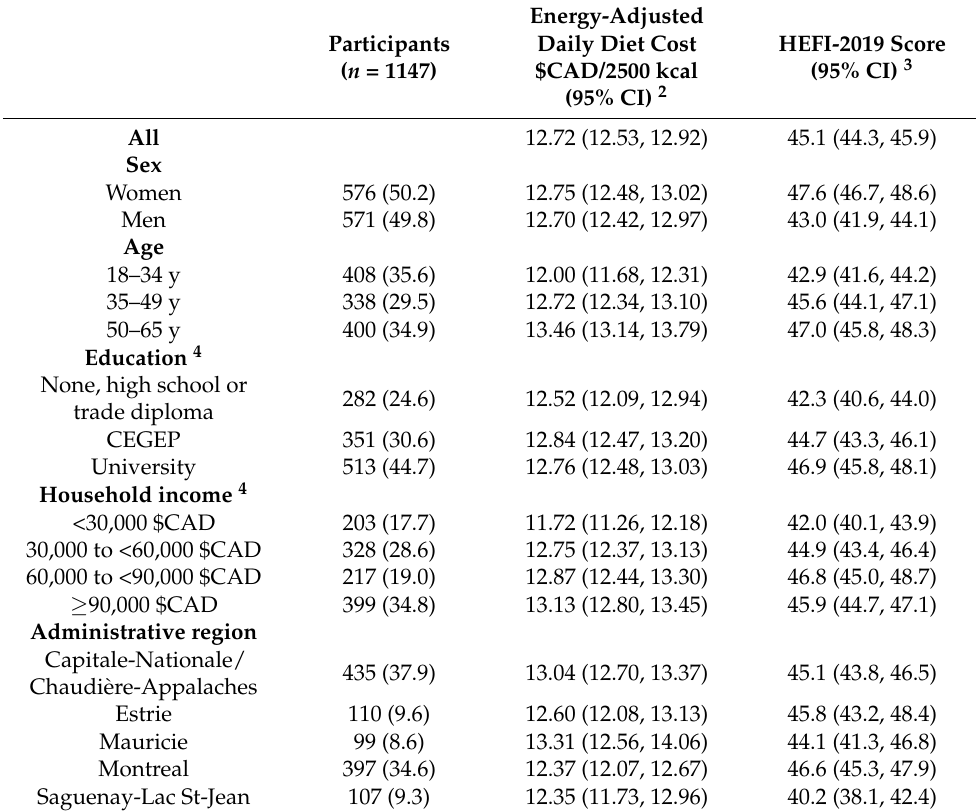
Table 1. Participants’ sociodemographic characteristics, energy-adjusted daily diet cost and Healthy Eating Food Index-2019 score 1